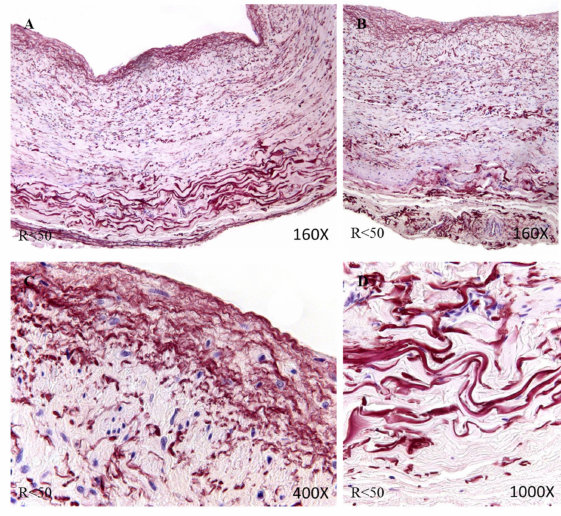
Figure 4. Images showing the elastic fibers in patients with R < 50 ( A – D ).